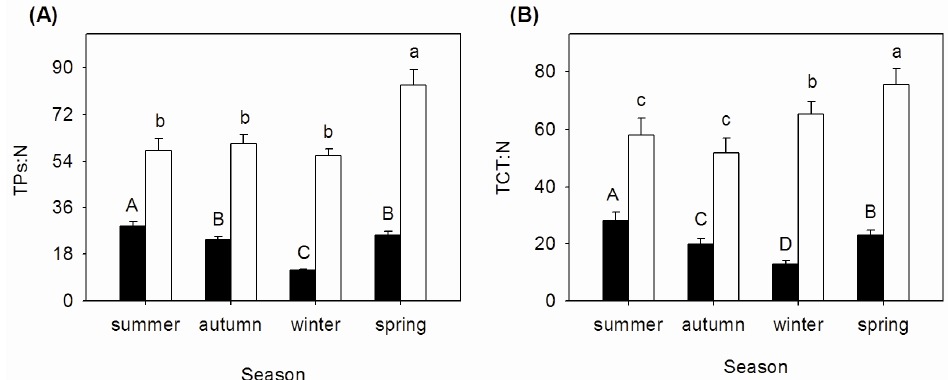
Figure 4. Seasonal changes of ( A ) total phenolics and nitrogen ratios (TPs:N) and ( B ) total condensed tannins and N ratios (TCT:N) in leaves of A. corniculatum . Symbols are black bars for mature leaves and white bars for senescent leaves. Different capital letters indicate significant differences among seasons for TPs:N and TCT:N ratios in mature leaves at p < 0.05. Different lowercase letters indicate significant differences among seasons for TPs:N and TCT:N ratios in senescent leaves at p < 0.05.